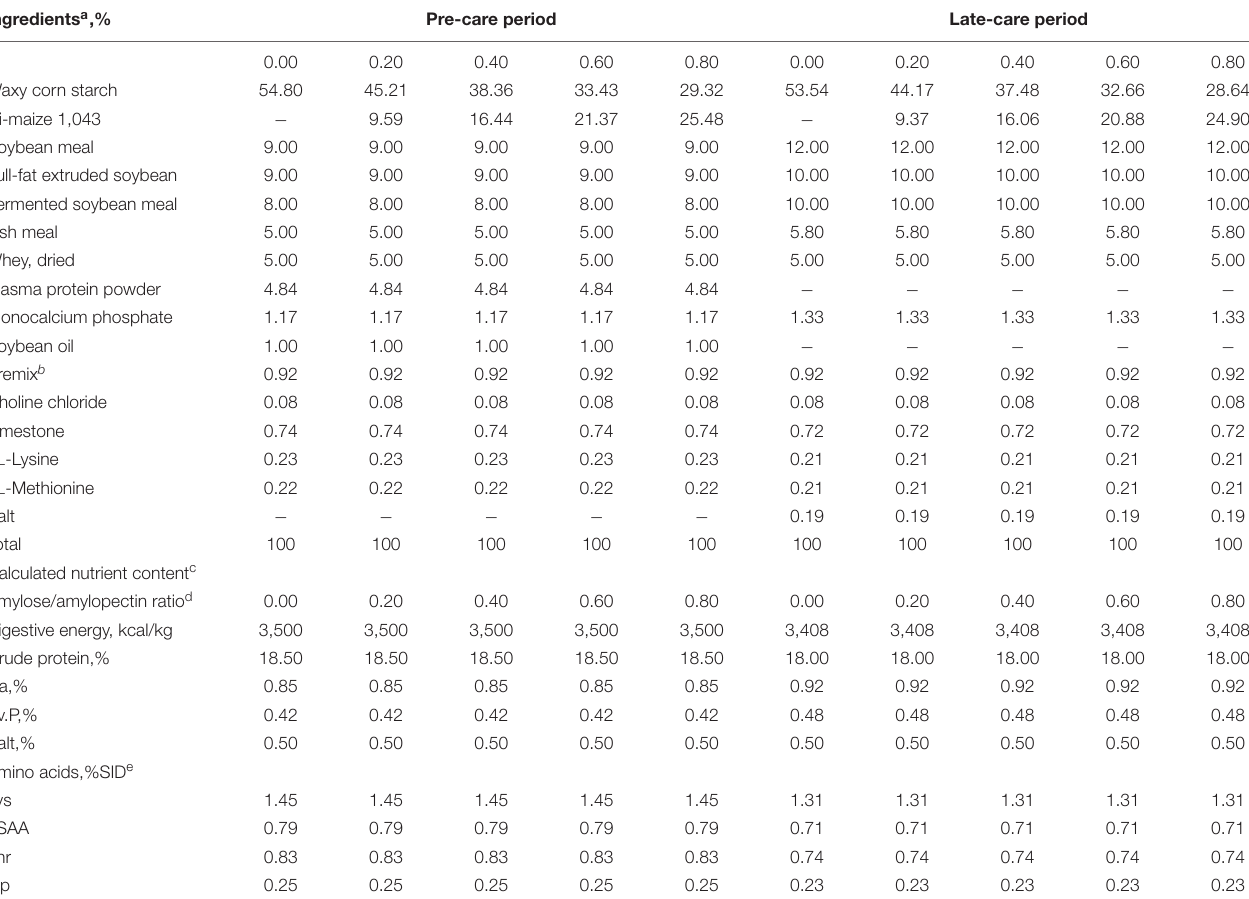
TABLE 1 | Composition of experimental diets (as-fed